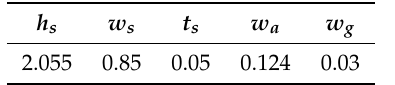
Table 2. Dimensions of the PSRR. Units are in